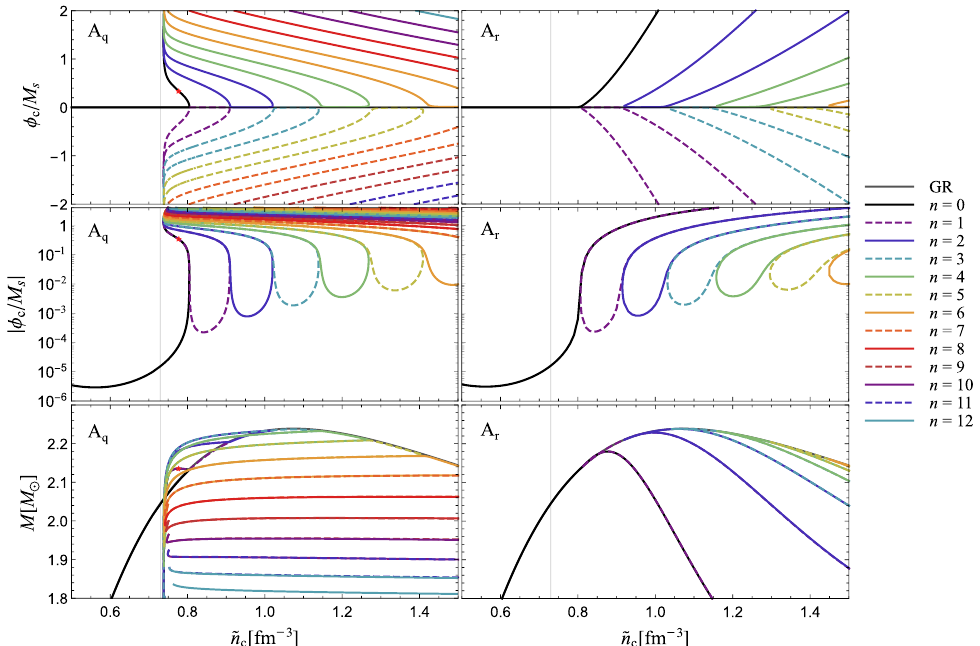
Figure 3. Sequences of equilibrium solutions describing SNSs for the quadratic—left column—and regularized—right column—variants of the symmetron model, both with M s / M Pl = 0.1. The central value of the scalar field ( φ c ) and the total mass ( M ) are shown as functions of the central number density (˜ n c ) in the two cases. In the second row, the absolute value of φ c is represented in log-scale for a complementary view of the solutions. Several branches of equilibrium solutions are identified, and classified according to the number n of nodes in the scalar field profile—note that not all of them are clearly discernible in the bottom panels due to a significant overlap in their properties. A vertical line is shown at ˜ n c = 0.730 fm − 3 , the critical value of the central number density, above which a pressure-dominated phase appears inside a GR NS. In the left column, a red star marks a marginally stable solution in the n = 0 branch: solutions with larger values of the scalar field are found to be unstable under radial perturbations (see discussion in the main text). Note that only solutions with central value of the scalar field | φ c | / M s (cid:46) 4 were computed, so that curves in the bottom-left panel are incomplete, as they would contain configurations with | φ c | / M s >